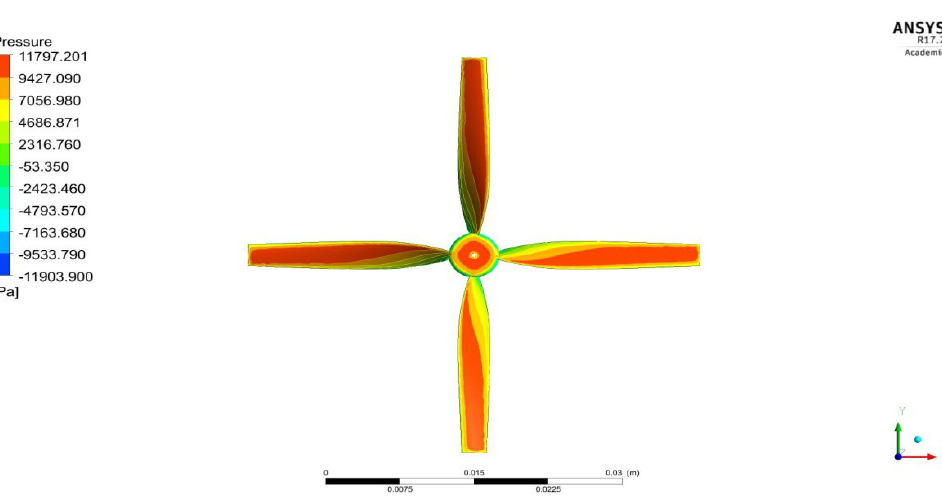
Figure 45. Hydrodynamic pressure distributions on the propeller—Front view.